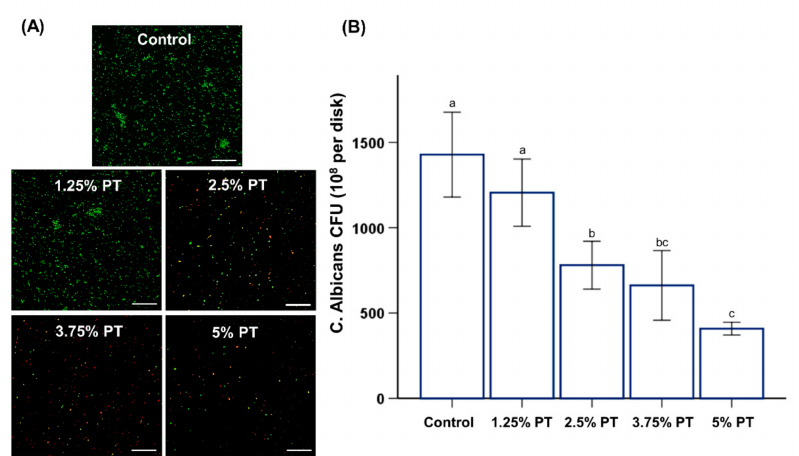
Figure 5. Representative live–dead staining images of C. albicans attached on the surfaces of PMMA samples; control, 1.25%PT,2.5%PT,3.75%PTand5%PTatamagnificationof5000 × ( A ),Colony-forming units (CFU) counts derived from fungi attached on the surfaces of PMMA samples ( B ). Same lowercase alphabetical letters above the bar graph indicate there are no significant di ff erences between the groups (e.g., there are no di ff erences between group with ‘a’ and another group with ‘a’ above the bar) ( p > 0.05). Di ff erences in lowercase alphabetical letters above the bar graph indicate significant di ff erences between the groups (e.g., there are di ff erences between the group with ‘a’ and the group with ‘b’.) ( p < 0.05).